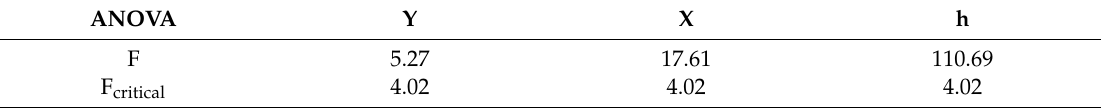
Table 7. Comparison of low-cost and geodetic GNSS antennas with ANOVA statistical test.